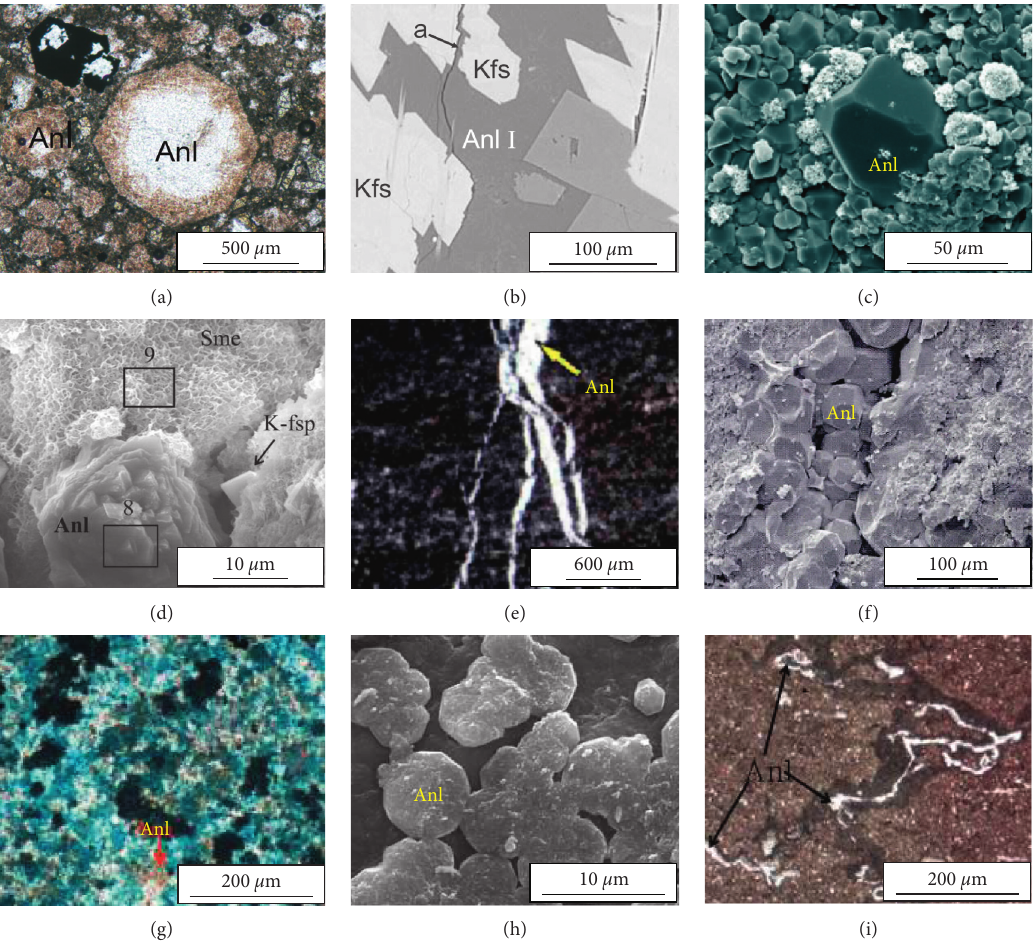
Figure 5: Occurrence forms of analcime. (a) Micrographs of euhedral and nearly rounded analcime from analcime-bearing volcanic rocks. (b) Magmatic texture comprised K-feldspar, albite (Ab), and analcime (Anl) [48]. (c) The crystalline tuff matrix is transformed into analcime [23]. (d) Growth of authigenic analcime from volcanic material [18]. (e) Micritic dolomite, in which fractures are partially filled with analcime [8]. (f) Micritic dolomite, in which fractures are filled with euhedral analcime [49]. (g) Analcime gel (yellow, indicated by red arrow) is filled in between micritic ankerite particles (green–blue) [23]. (h) Subhedral globules of analcime gel, with isolated euhedral analcime crystals occupying pore spaces in the center left and upper right [12]. (i) Liquefaction veins are filled with analcime cement in massive dolomite